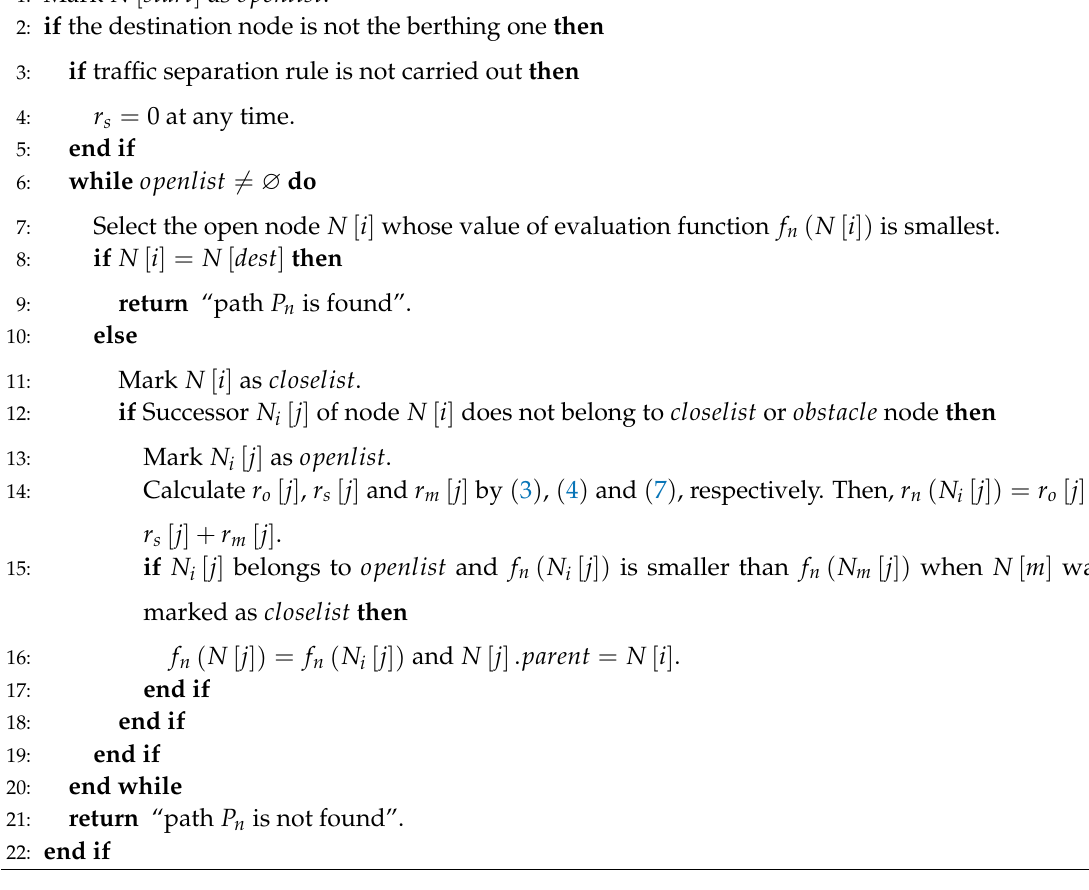
Algorithm 2 Normal path generation with the improved A-Star algorithm ( N [ start ] → N [ dest ]